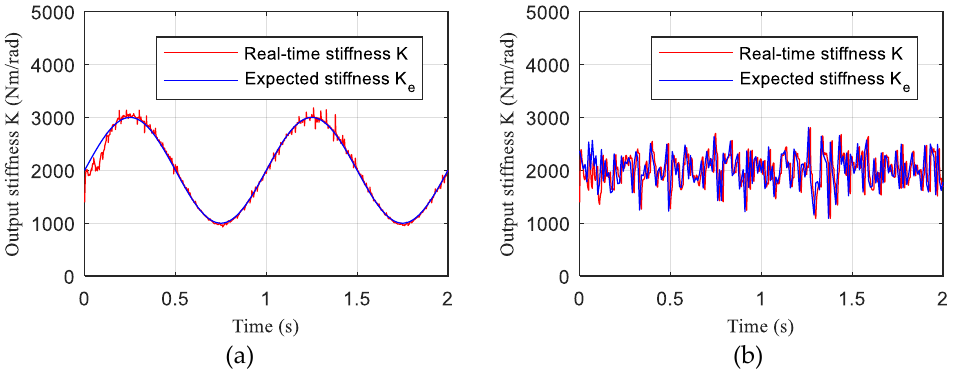
Figure 19. Real-time dynamic stiffness tracking curve. ( a ) The expected joint stiffness is a sine wave signal. ( b ) The expected joint stiffness is a random signal. signal. ( b ) The expected joint sti ff ness is a random signal.